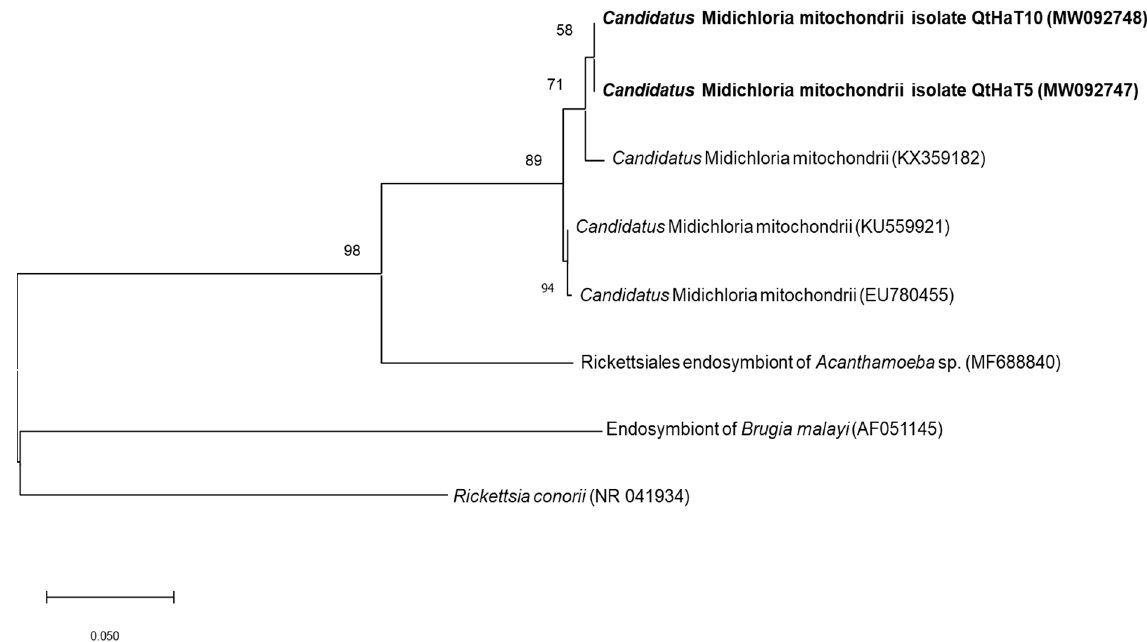
Figure 1. Molecular Candidatus M. mitochondrii identification according to phylogenetic analysis using the maximum likelihood method and Tamura-Nei model with the 16S rRNA gene. The analyzed sequences are in bold. The accession numbers for nucleotide sequences from GenBank are presented with species names. The branch numbers mean bootstrap support (1000 replicates). The tree is drawn to scale, with branch lengths measured in the number of substitutions per site. Animals 2020 , 10 , x